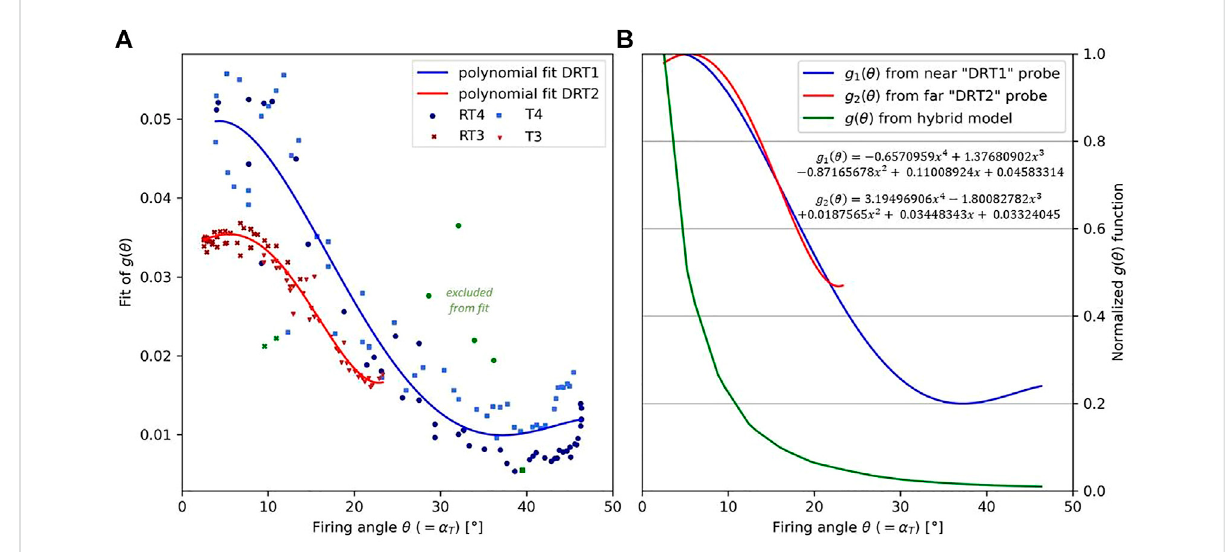
FIGURE 12 (A) Fit of the ion angular distribution function g ( θ ) from the Express-A measurements. (B) Comparison between the normalized ion angular distribution function from experimental fi ts and thruster hybrid model results. The ion energy distribution function is a shifted Maxwellian ( ε s (cid:2) 250eV , T i = 0.2